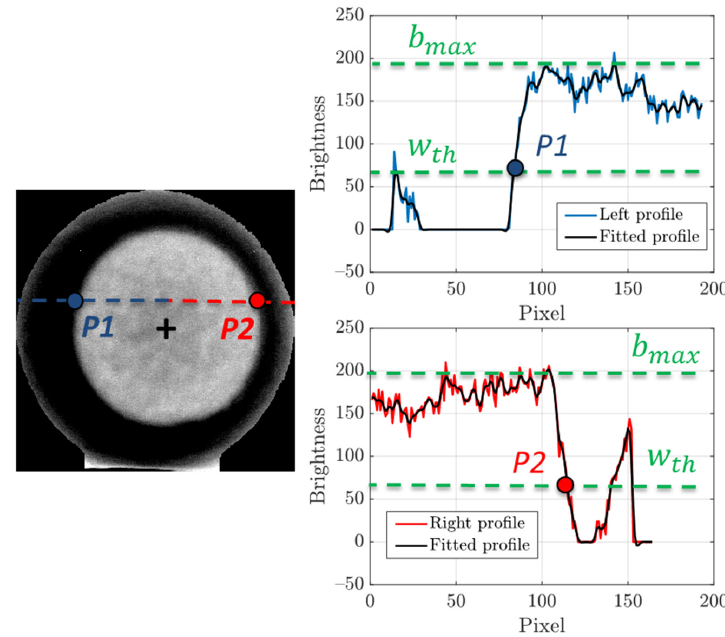
Figure 7. Identification of key points of the fitting ellipse for the air chamber perimeter.